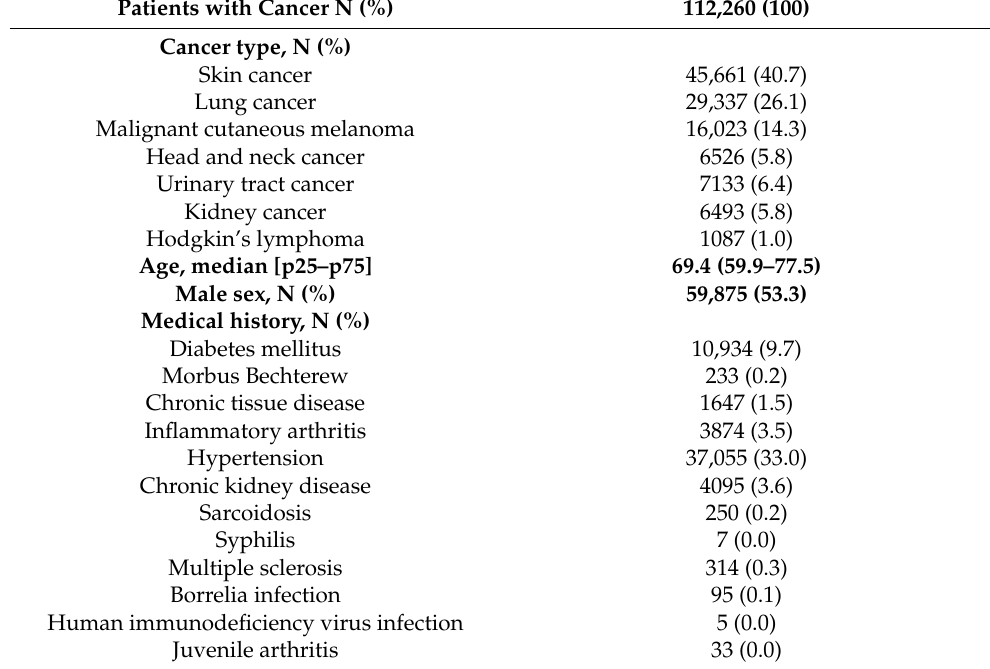
Table 1. Characteristics of patients with cancer at time of